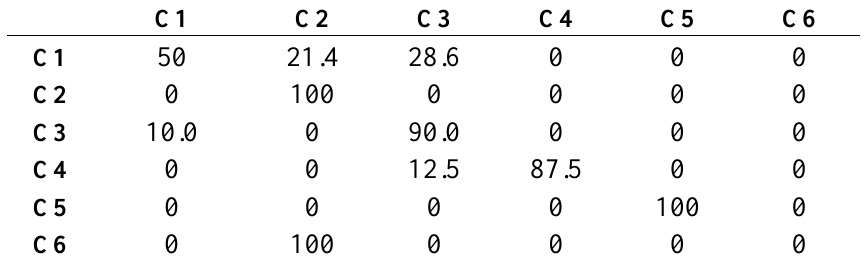
Table 6. Confusion matrix for the context recognition with location features (Unit: %).